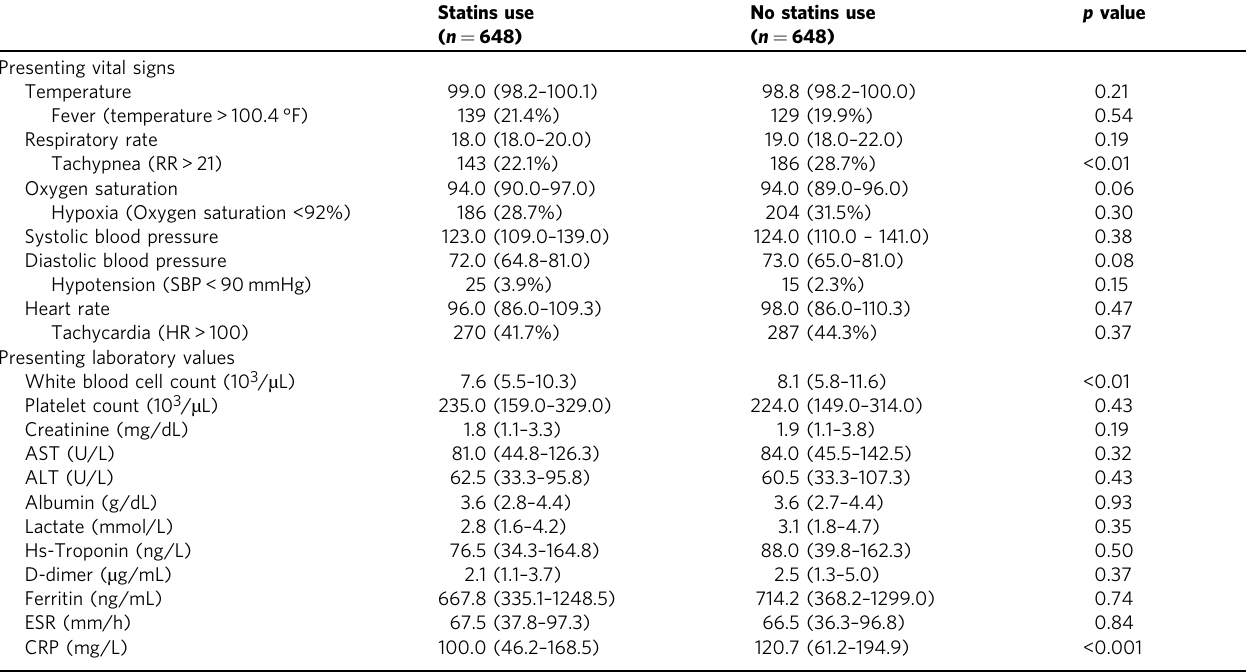
Table 2 Presenting vital signs and laboratory data in the propensity-matched cohort of patients hospitalized with COVID-19.